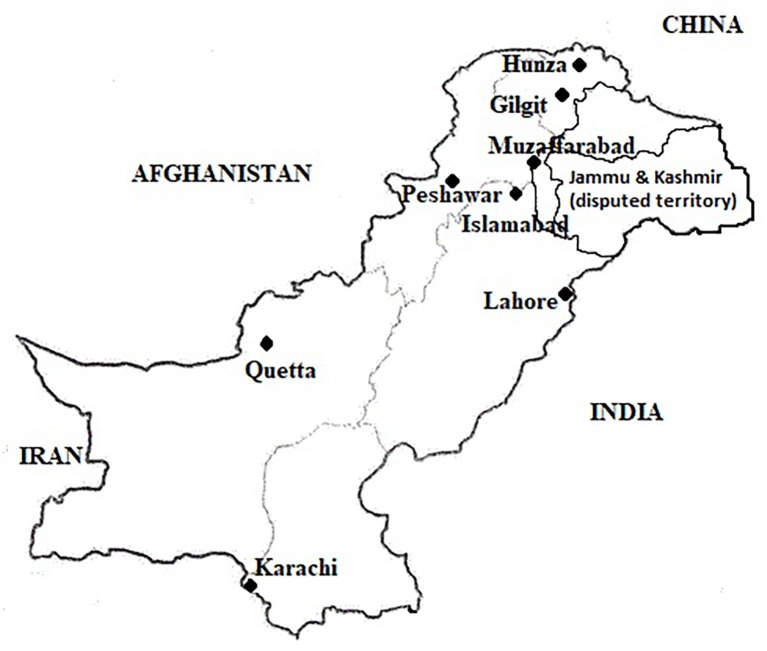
Geographical distribution of sampling sites within Pakistan.